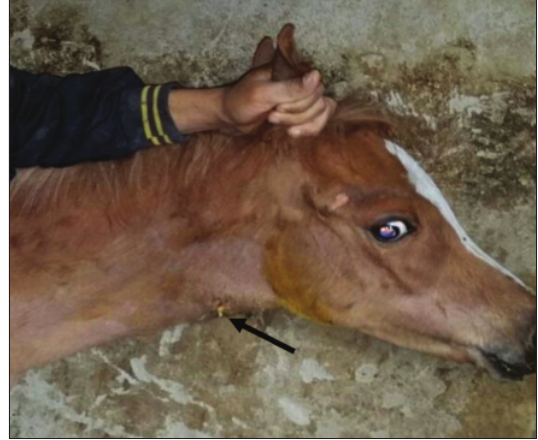
Figure-6: Horse suffering from strangles showing drained abscess of retropharyngeal lymph node (arrow).